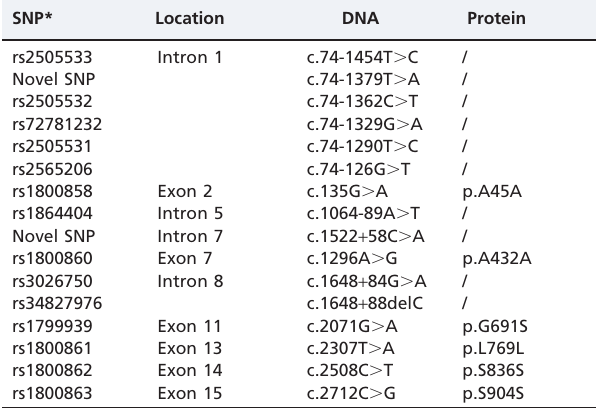
Table 1 - Sixteen RET intragenic SNPs that were genotyped in patients with MTC alone or HSCR/MTC from a newly reported FMTC/MEN2